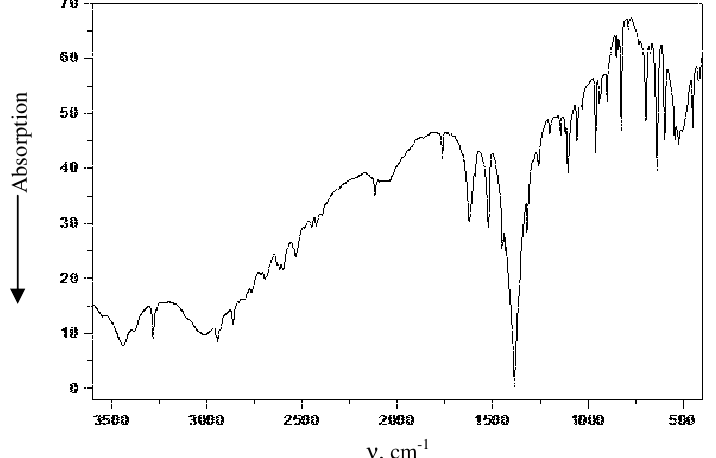
Figure 4. The N-H…O hydrogen-bonded in Co(H The IR spectrum of crystalline Co(H assign the IR bands to vibration modes, we have examined the modes and frequencies observed in similar compounds 17,18 .